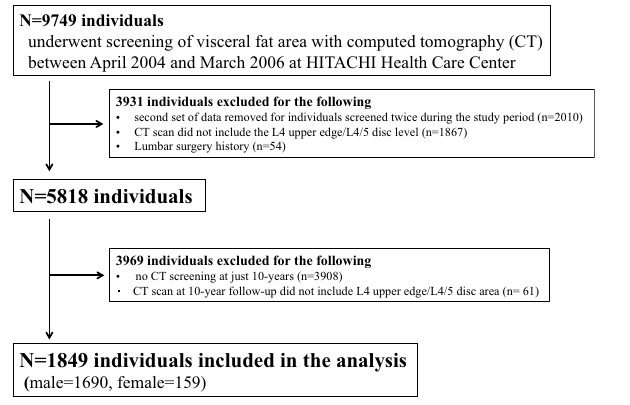
Figure 1. Study flow